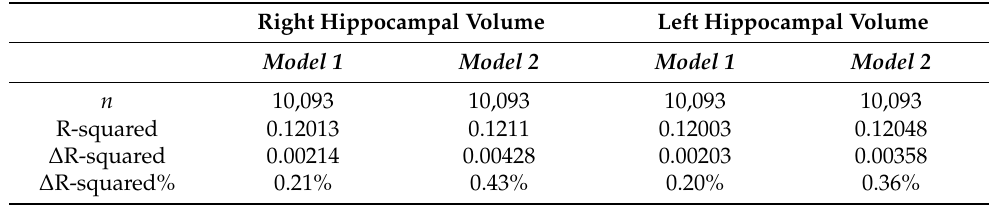
Table 2. The fit of our models on the effects of right and left hippocampal volumes on list sorting working memory.